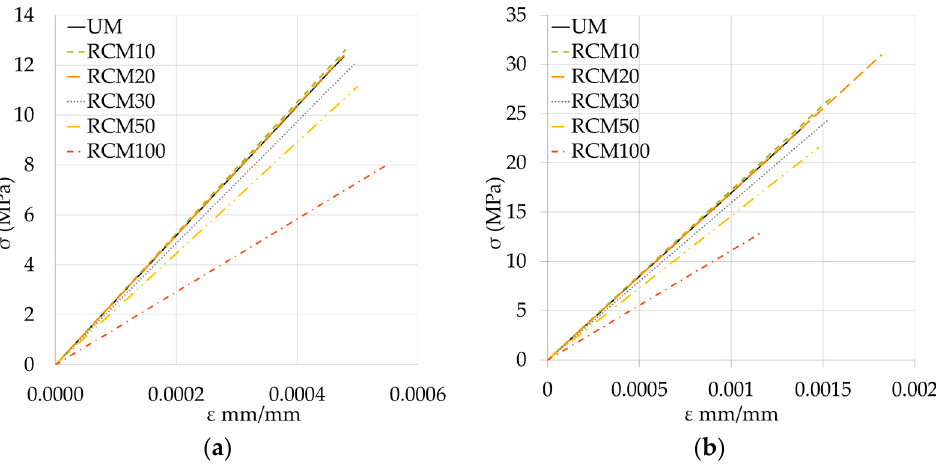
Figure 12. Curve σ - ε simulated for the RCM: ( a ) up to σ elastic ; and ( b ) up to σ max.